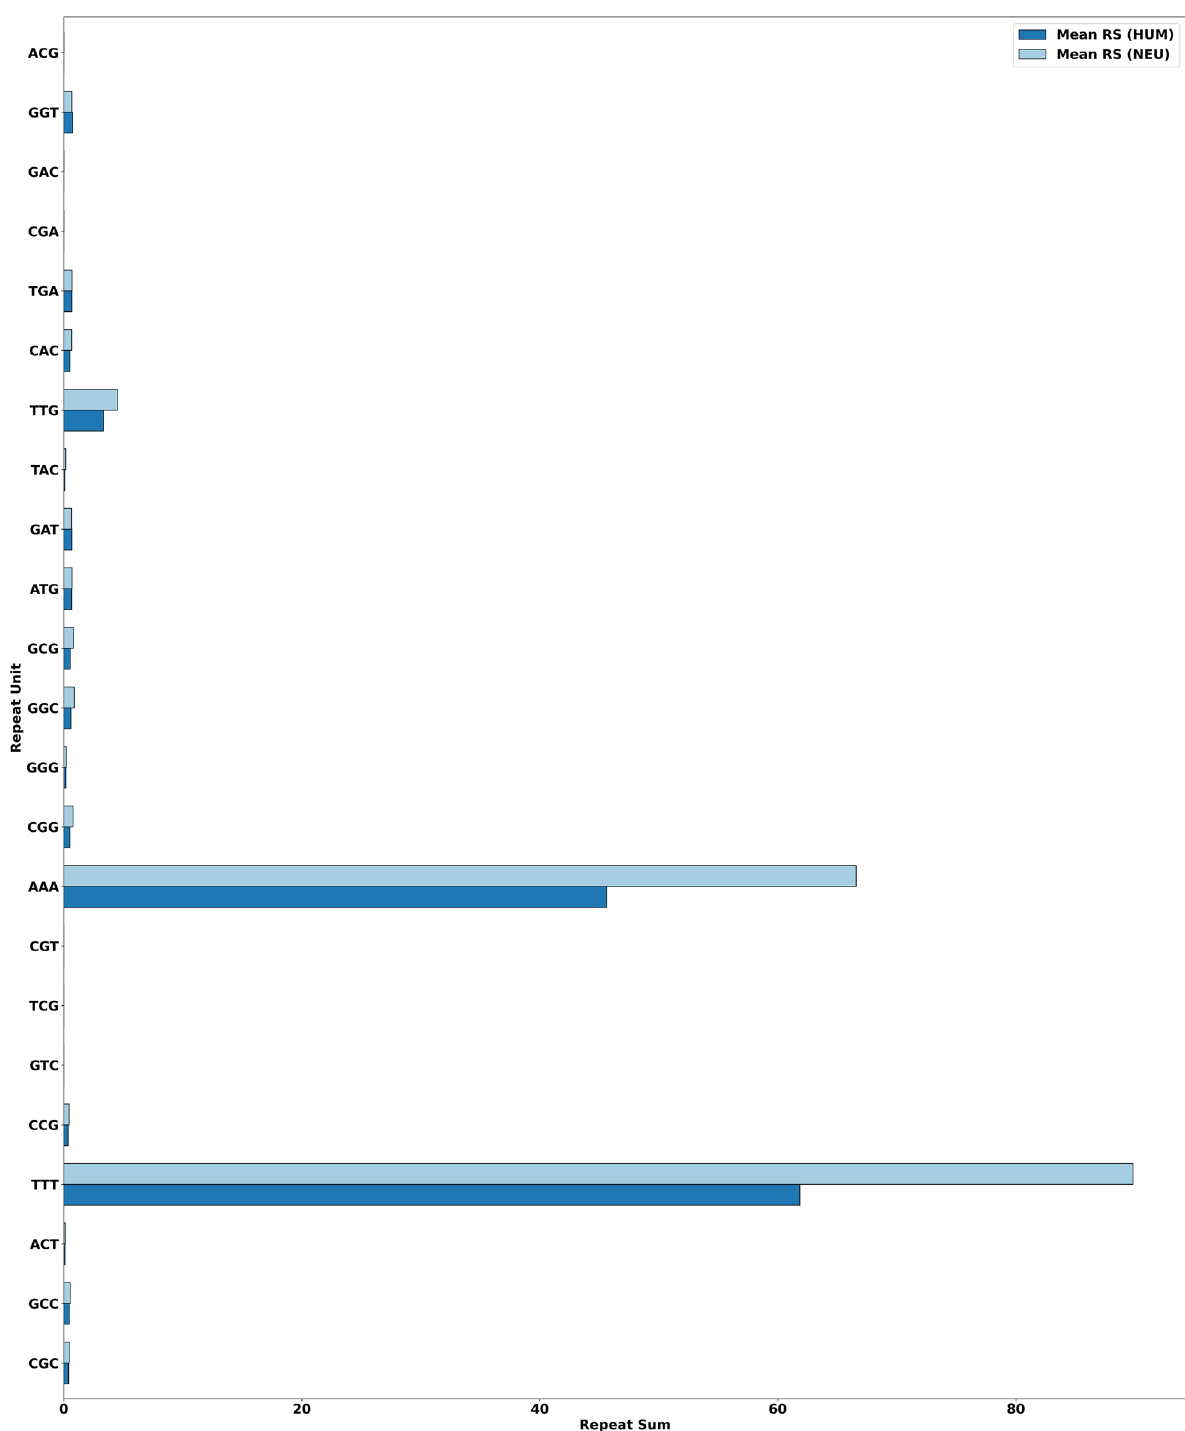
Figure 4. Mean distribution of RS of the least significant RUs (LSRUs) between the two datasets, where LSRU CGC has the highest adjusted p value, followed by LSRU GCC, and so